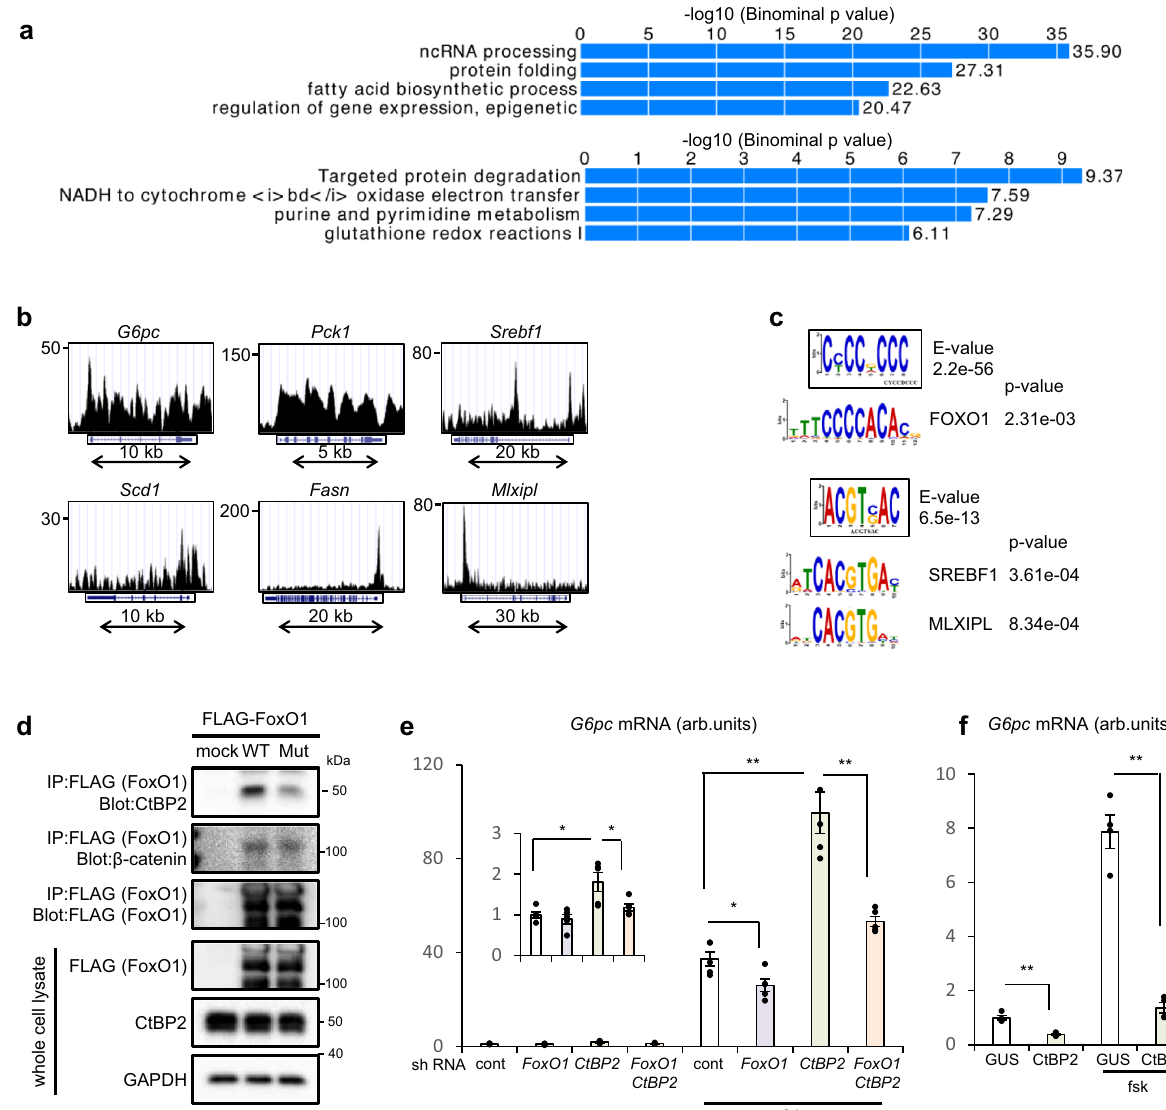
Fig. 1 Unraveling CtBP2 cistrome leads to an identi fi cation of CtBP2/FoxO1 complex. a – c CtBP2 ChIP-seq analysis in normal mouse liver tissues (6-h fasted). a Gene ontology analysis. Upper: biological process, lower: BioCyc pathway. b ChIP-seq peaks at representative metabolic gene loci. c Motif analysis of CtBP2 binding sites. The motifs enclosed by a rectangle are CtBP2-binding motifs enriched in the ChIP-seq. Prediction of known transcription factors targeted by CtBP2 based on sequence similarity is shown below. The statistical evaluation was performed based on the speci fi c algorithm 85 . d Mutation of the PSDL motif in FoxO1(Mut: PSDL > PSAS) diminishes CtBP2/FoxO1 interaction in HEK293 cells. e , f Primary hepatocytes were stimulated with vehicle or 2 μ M forskolin (fsk) after knockdown ( e ) or overexpression ( f ) of CtBP2. e The effect of CtBP2 and/or FoxO1 knockdown on G6pc expression ( n = 5, biologically independent cells). The y -axis scale is expanded in the inset to show the data in the absence of fsk. The p values are as follows: 0.011 for sh-cont vs sh- CtBP2 , 0.036 for sh- CtBP2 vs sh- FoxO1 , 0.022 for sh-cont/fsk vs sh- FoxO1 /fsk, 1.6 × 10 − 4 for sh-cont/fsk vs sh- CtBP2 /fsk, 9.4 × 10 − 4 for sh- CtBP2 /fsk vs sh- FoxO1 / CtBP2 /fsk. f G6pc expression following CtBP2 overexpression ( n = 4, biologically independent cells). The p values are as follows: 5.6 × 10 − 4 for GUS vs CtBP2, 5.6 × 10 − 5 for GUS/fsk vs CtBP2/fsk. Data are expressed as the mean ± SEM. * and ** denote p < 0.05 and p < 0.01 evaluated by unpaired two-tailed Student ’ s t -test, respectively. Source Data are provided as a Source Data fi FoxO1-binding partner, β -catenin, in HEK293 cells (Fig. 1d and Supplementary Fig. 2d, e), indicating that CtBP2 directly and speci fi cally binds to FoxO1 through its PSDL motif whereas CtBP1 may bind to FoxO1 indirectly or through other interaction site(s).